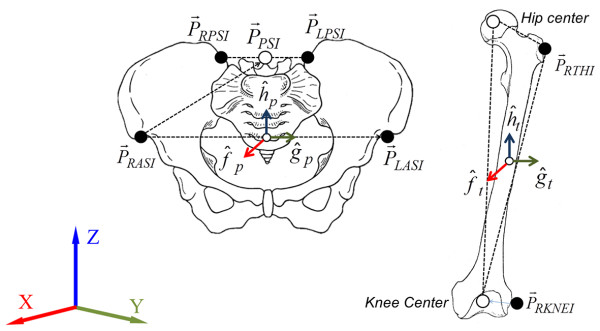
Anatomical reference system of the pelvis and femur.